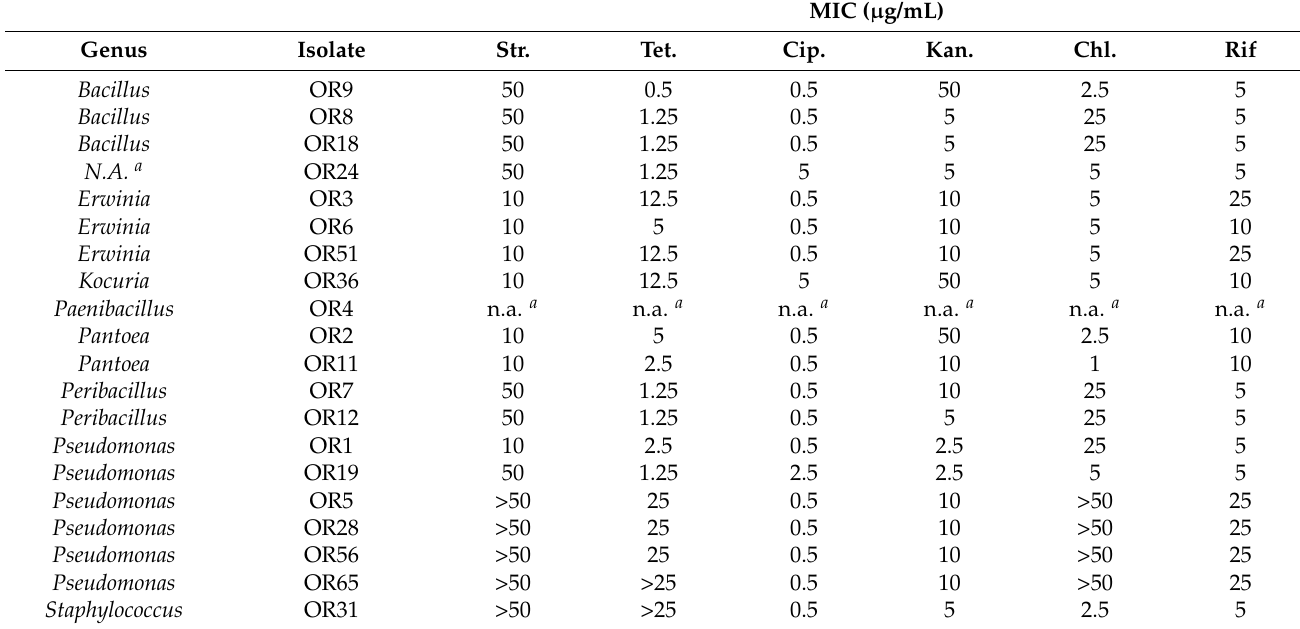
Table 3. Minimal inhibitory concentration of the tested antibiotics.